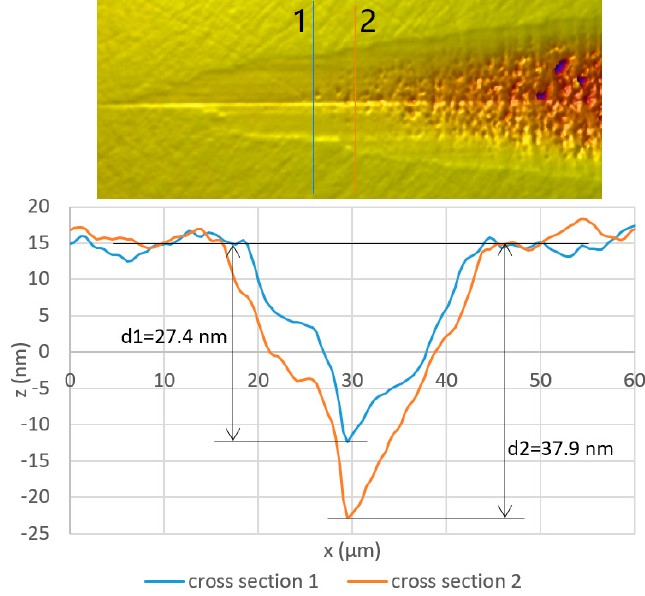
Figure 10. Cross-sectional profiles start and end of transitional range.